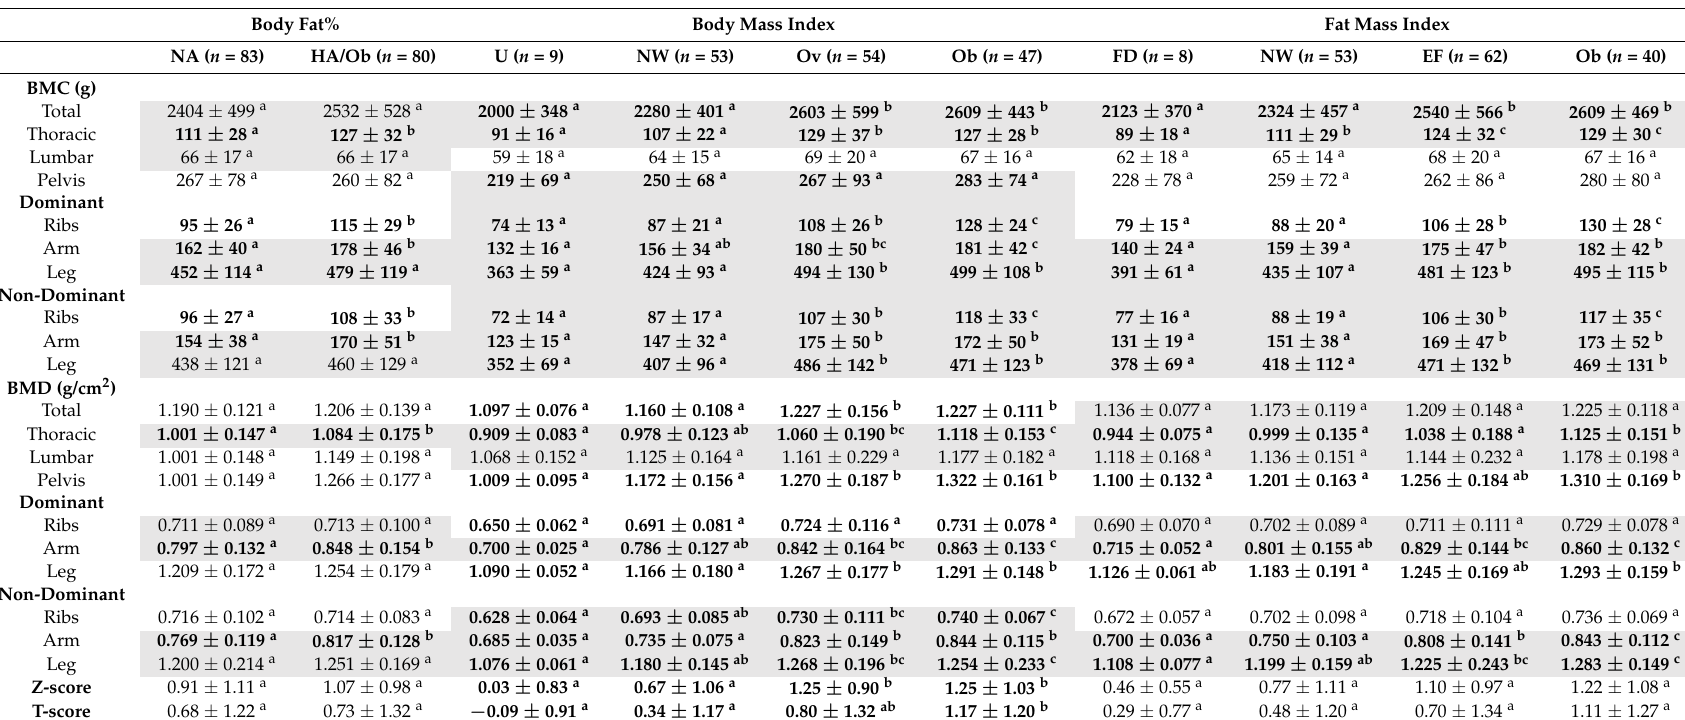
Table 2. Bone mineral content (BMC) and bone mineral density (BMD) characteristics in 163 untrained participants categorized by body fat%, body mass index (BMI) and fat mass index (FMI)